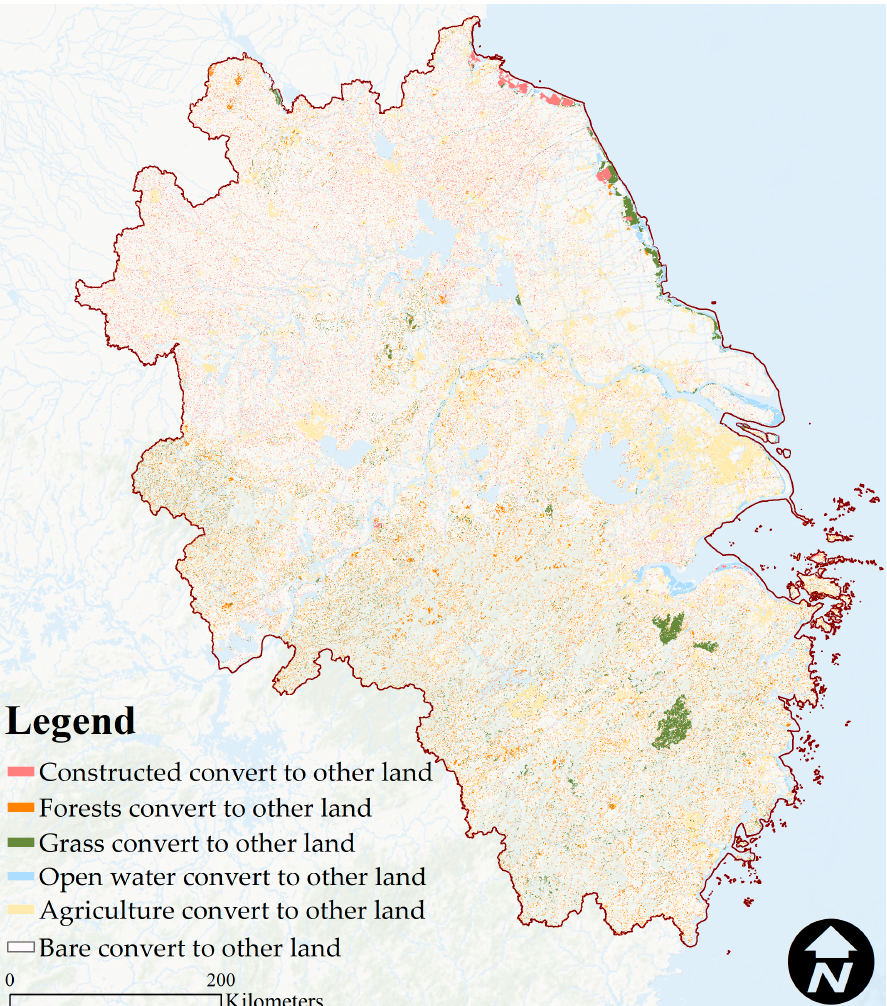
Figure 4. Spatial distribution of land use type change in the Yang tz e River Delta.